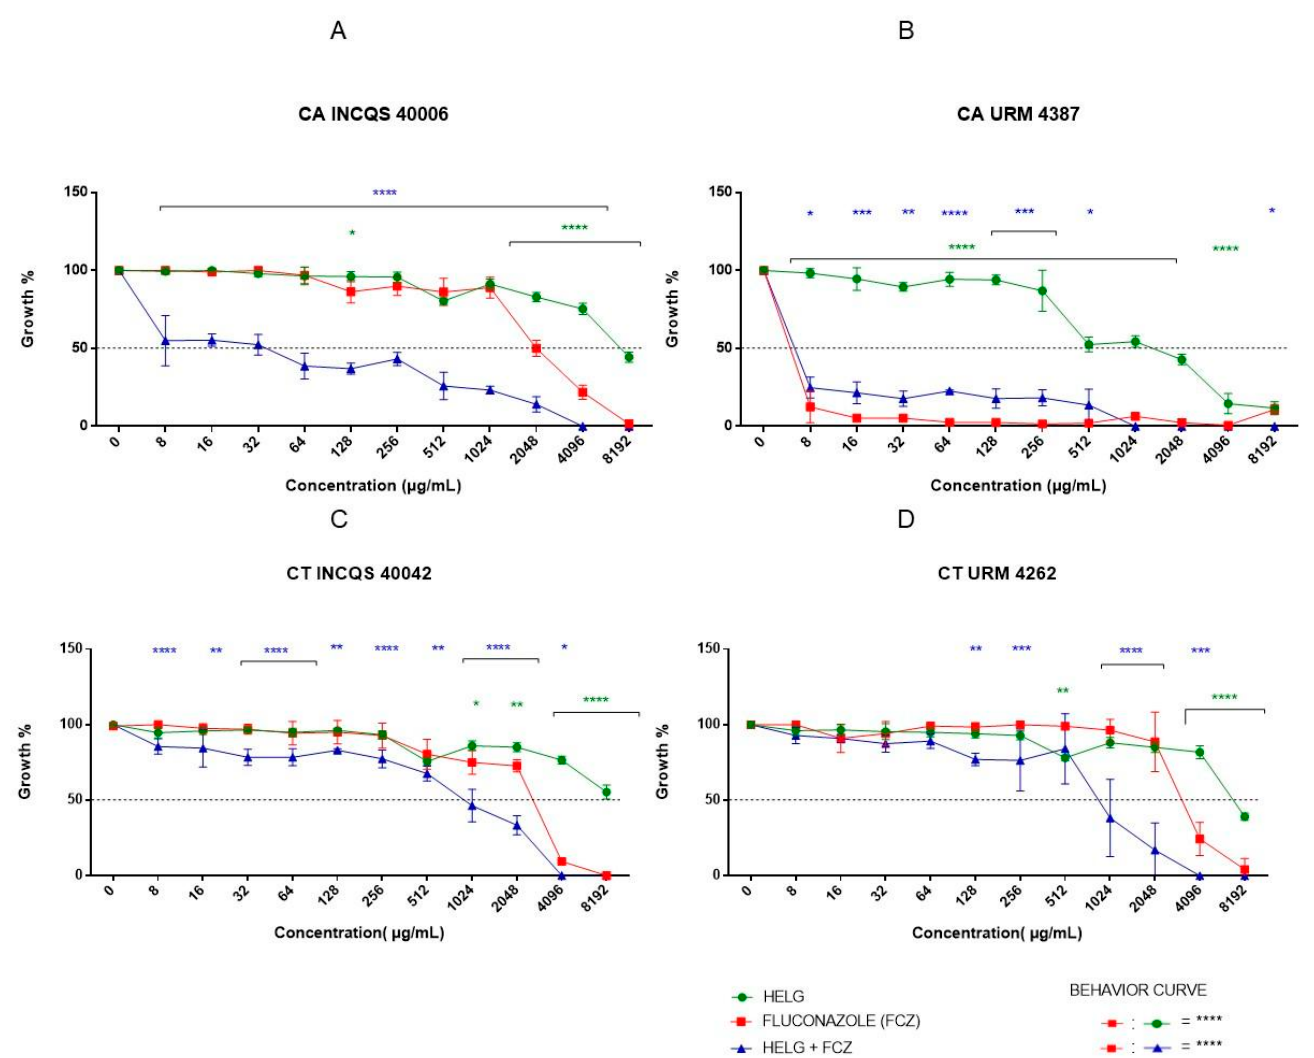
Figure 3. Cell viability curve of HELG alone and in combination with Fluconazole. Candida albicans INCQS 40006 ( A ), Candida albicans URM 4387 ( B ), Candida tropicalis INCQS 40042 ( C ) and Candida tropicalis URM 4262 ( D ). Statistical significance was determined considering the difference in relation to fluconazole, **** = p < 0.0001; *** = p < 0.001; ** = p < 0.01; * = p < 0.1.